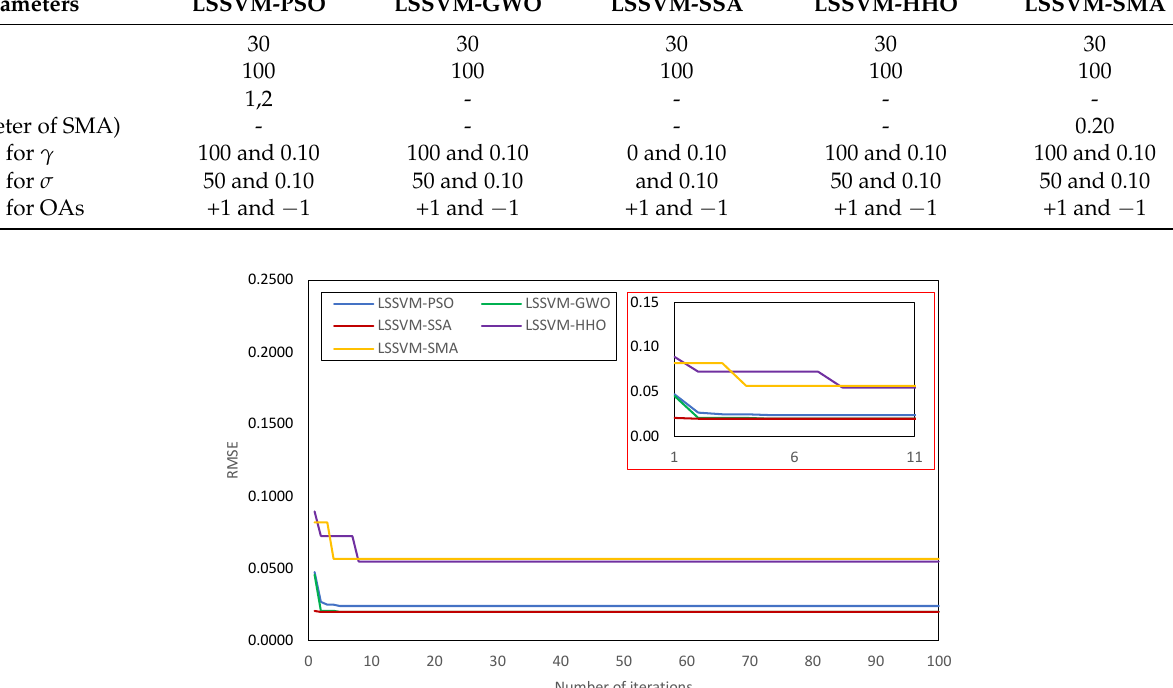
Table 2. Details of different parametric for hybrid LSSVMs.